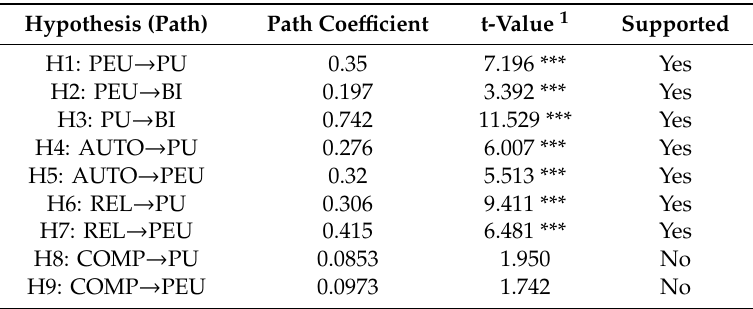
Table 5. Research hypotheses